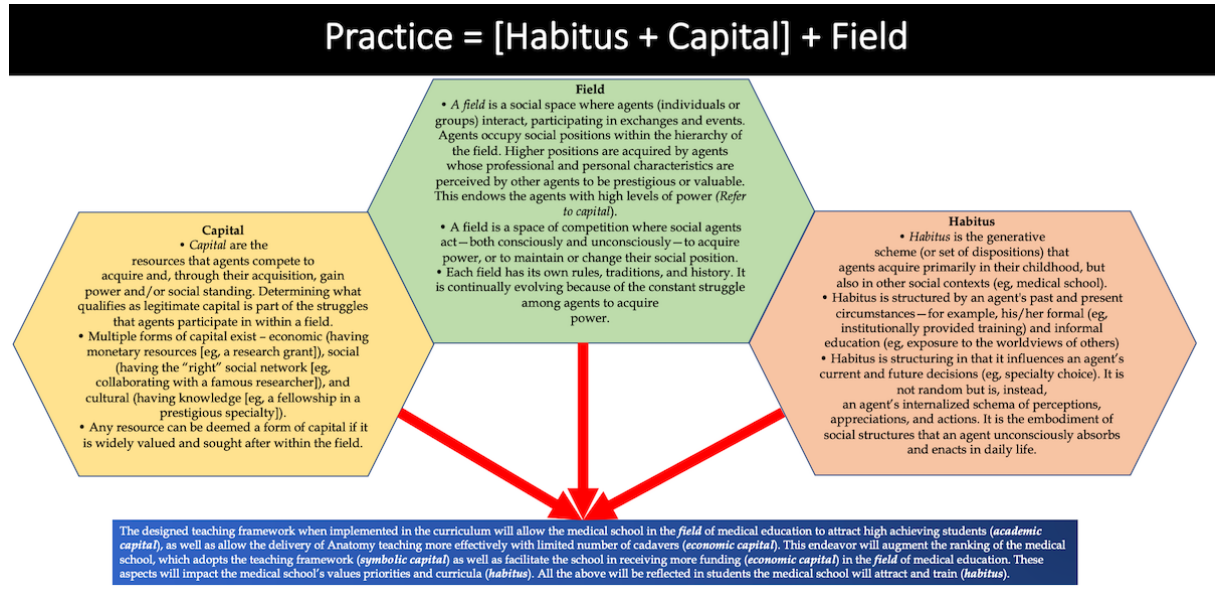
Figure 5. Bourdieu’s Theory of Practice. The figure elaborates on three intimately related concepts: field, capital, and habitus. The text box in blue elaborates how Bourdieu’s Theory of Practice when applied to the current context demonstrates the benefit of the teaching framework being adopted by a medical school. The concept of the figure was derived from Brosnan